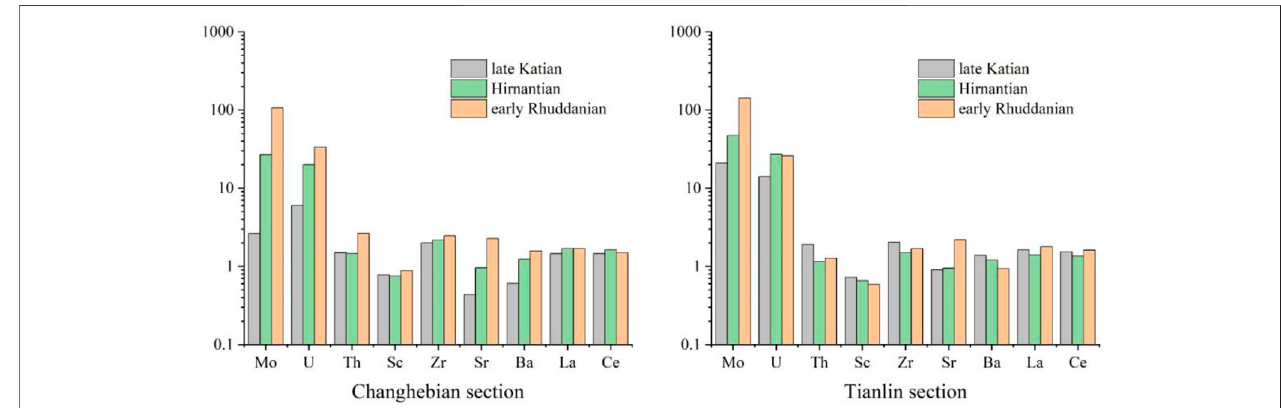
FIGURE 5 | Enrichment of trace elements in the Changhebian and Tianlin sections.